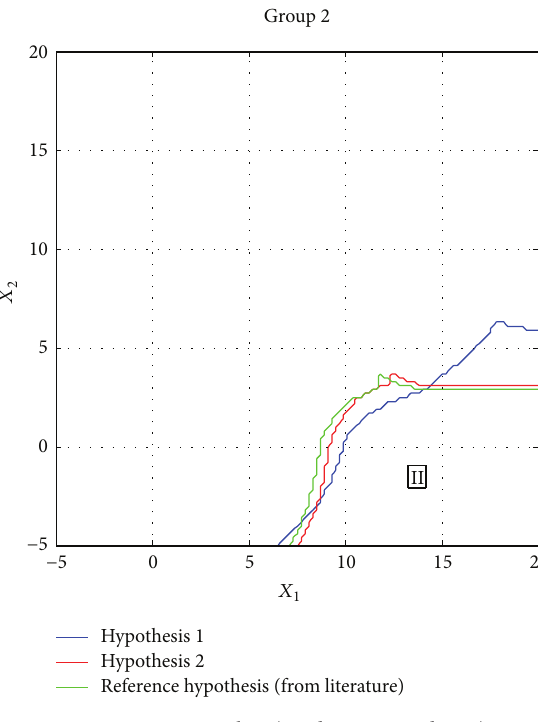
Figure 8: Production policy for 𝑃 2 and setup policy ( 𝑃 2 to 𝑃 1 ).